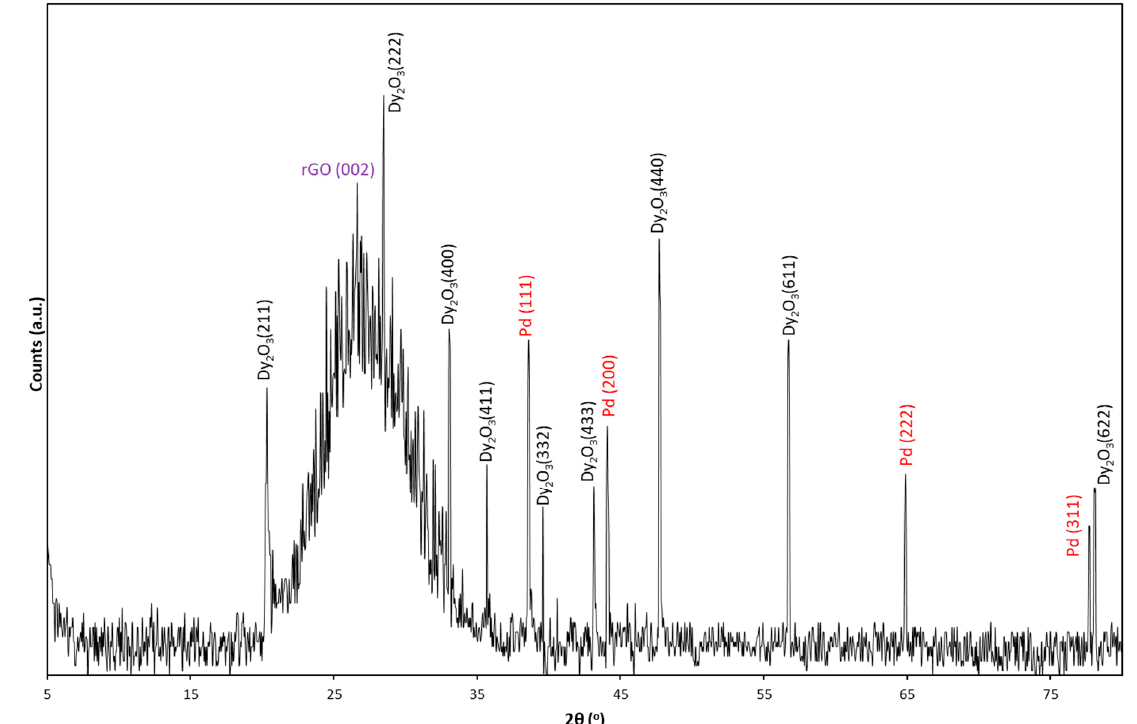
Figure 3. X-ray diffraction pattern of Dy 2 O 3 -Pd-PDA/rGO nanocomposite.